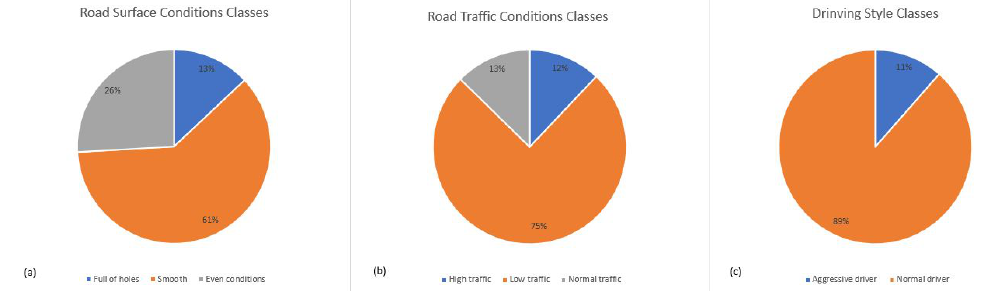
Figure 2. The distribution of each class in the dataset: ( a ) Label distribution as a percentage for the road surface conditions. ( b ) Label distribution as percentage for the road traffic conditions. ( c ) Labels distribution as a percentage for the driving